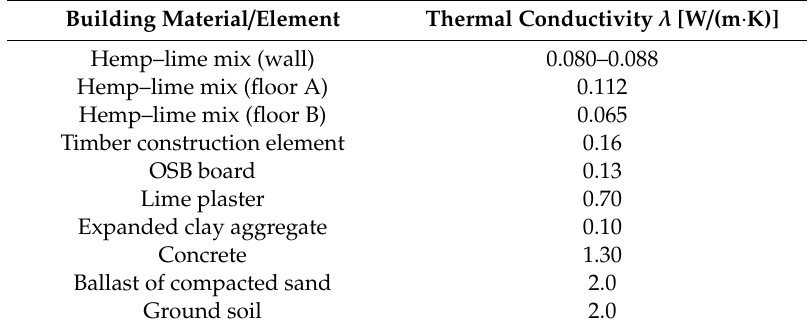
Table 2. The thermal conductivity of the main materials and elements.